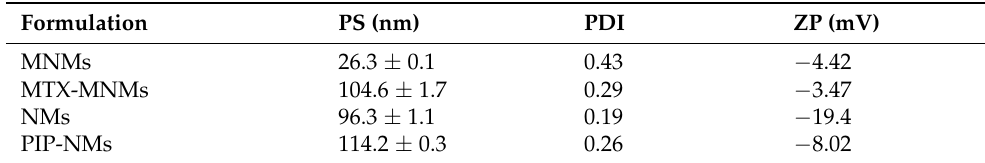
Table 1. Particle size and surface charge evaluation of the developed plain and drugs-loaded pluronic nanomicelles as determined by DLS.